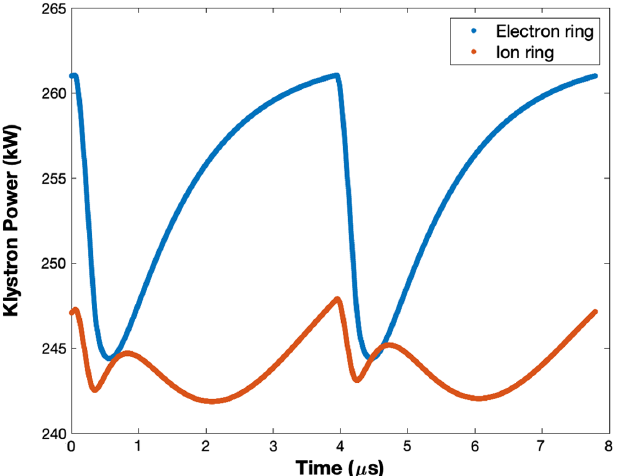
FIG. 5. Klystron power with direct loop feedback.